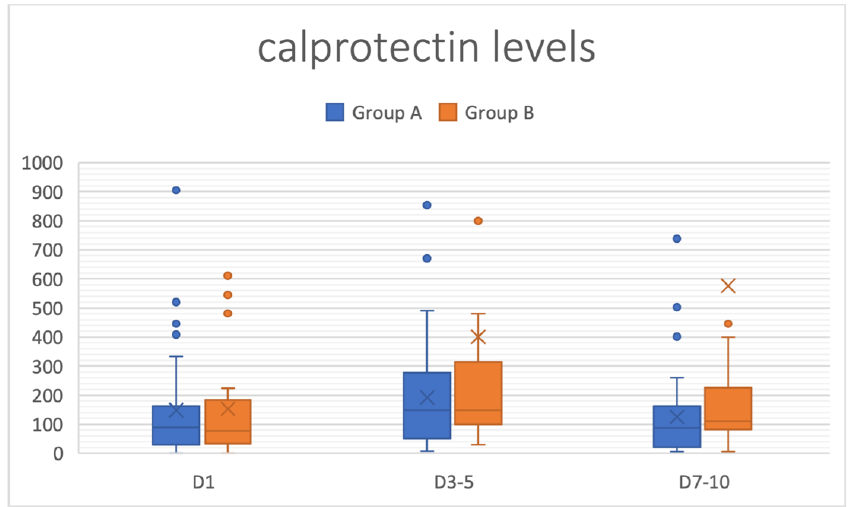
Figure 2. Evolution of mean levels of fecal calprotectin in Group A (supplemented with the probiotic mix) and Group B (control group; standard treatment without probiotics) from enrolment to Days 3-5 and Days 7-10.